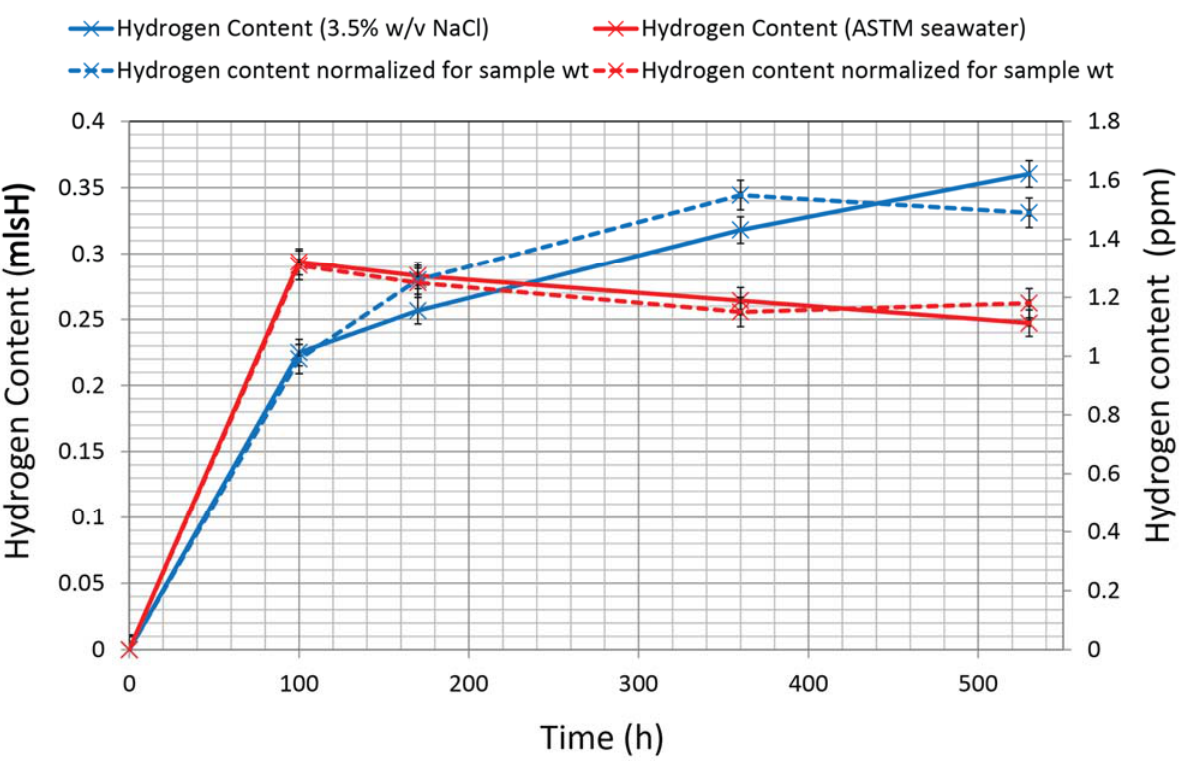
Figure 10 . Diffusible hydrogen